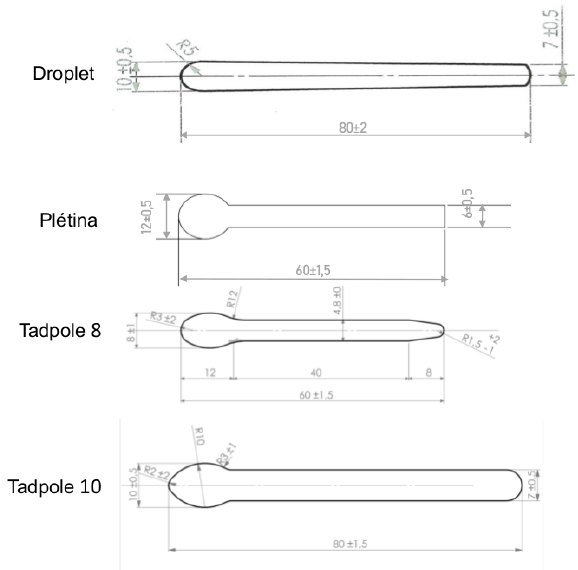
Figure 3. Bar shapes dimensions: thickness (b) and depth